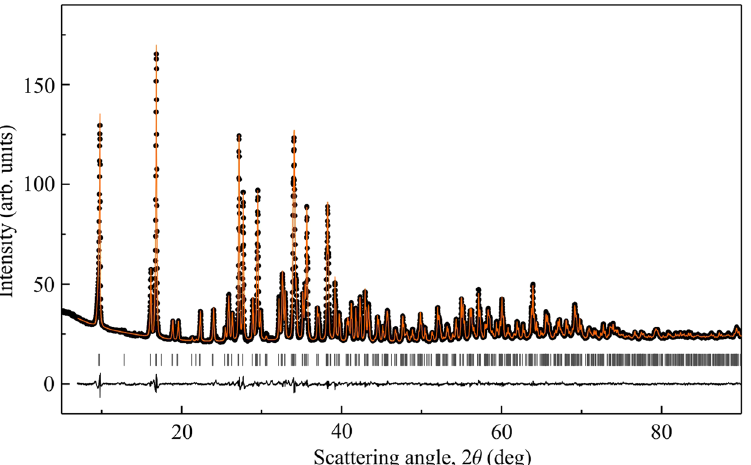
Figure 1. Rietveld refinement of the powder XRD data for the KCu 5 O 2 (SeO 3 ) 2 Cl 3 sample used in this work. Ticks show peak positions according to the lattice parameters given in the text. The refinement residuals are R I = 0.019, R p = 0.013, and R wp =